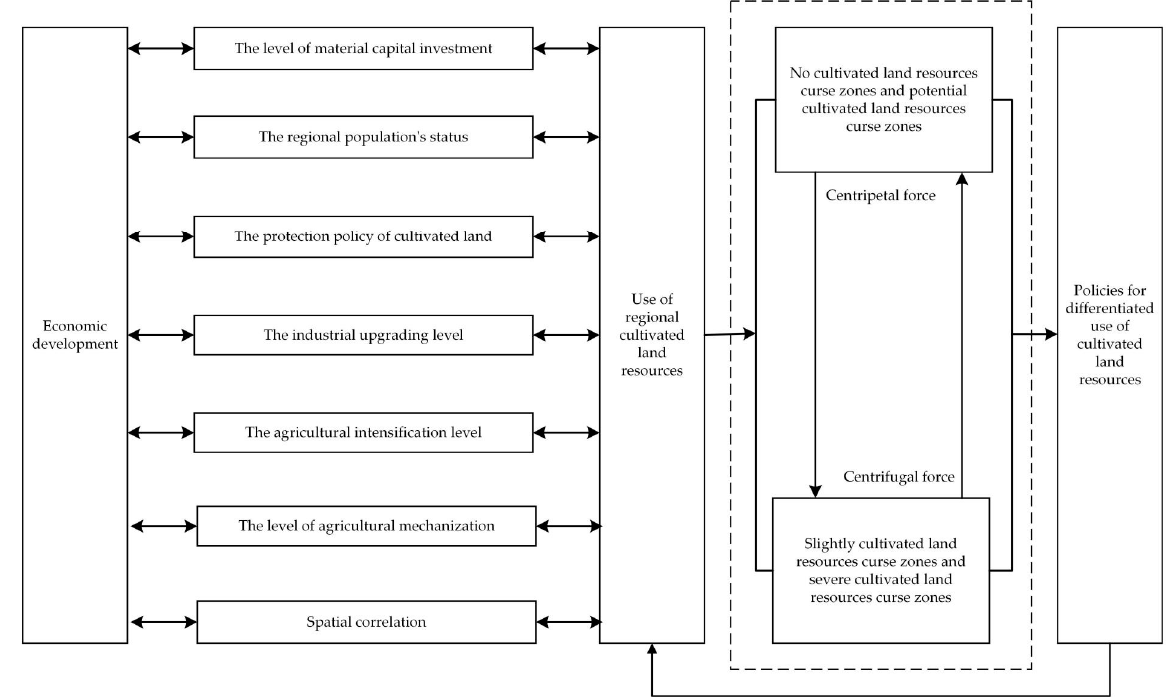
Figure 6. The transmission mechanism of the cultivated land resource curse in Jianghan Plain.